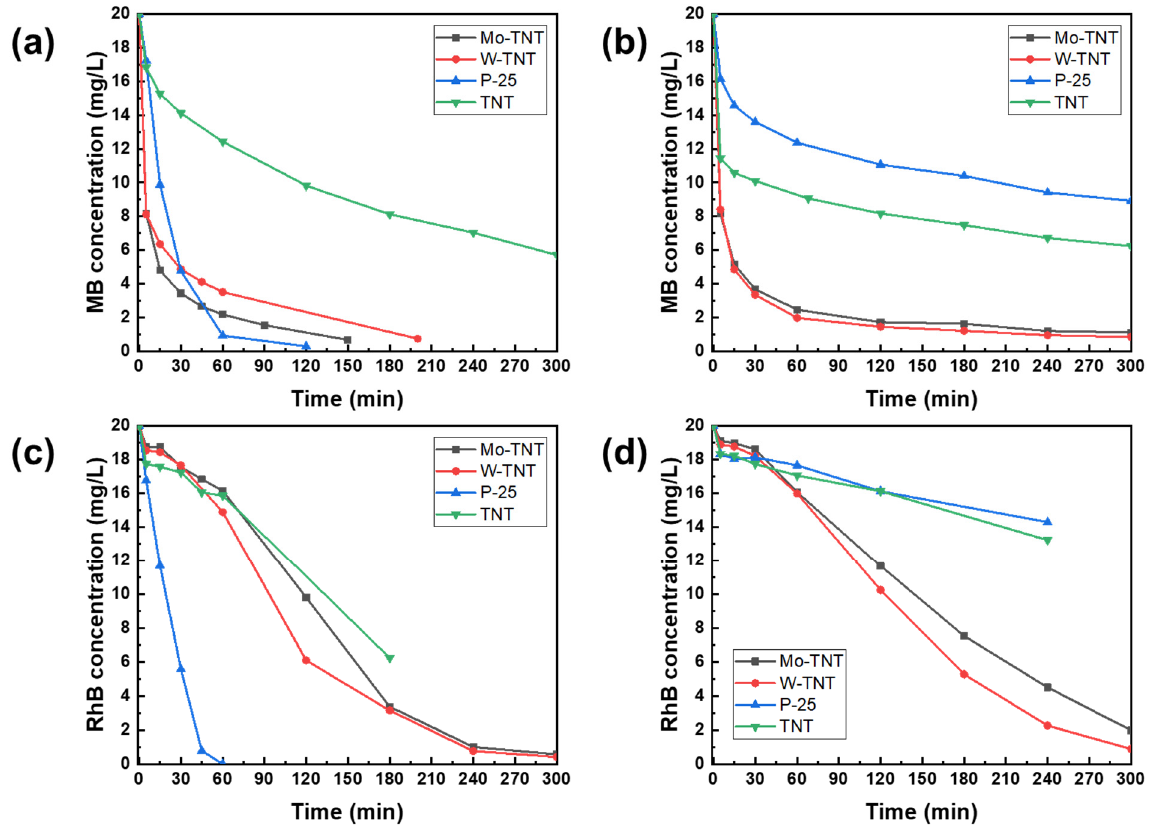
Figure 7. Photocatalytic activity of synthesized Mo-TNT and W-TNT nanostructures under UV–vis light irradiation: ( a ) MB degradation under UV light irradiation; ( b ) MB degradation under visible light irradiation; ( c ) RhB degradation under UV light irradiation; and ( d ) RhB degradation under visible light